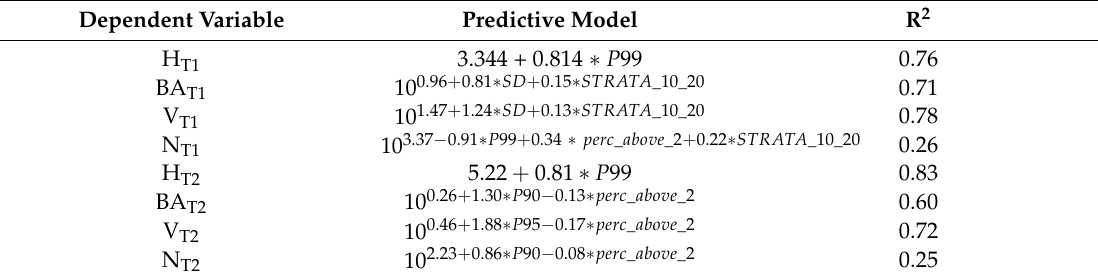
Table 4. Predictive models for top height (H), basal area (BA), total plot volume (V), and stem density (N). Dependent variables denoted with T1 were modeled using ALS data acquired at T1 (2008), while T2 variables were modeled using DAP data from T2 (2015).